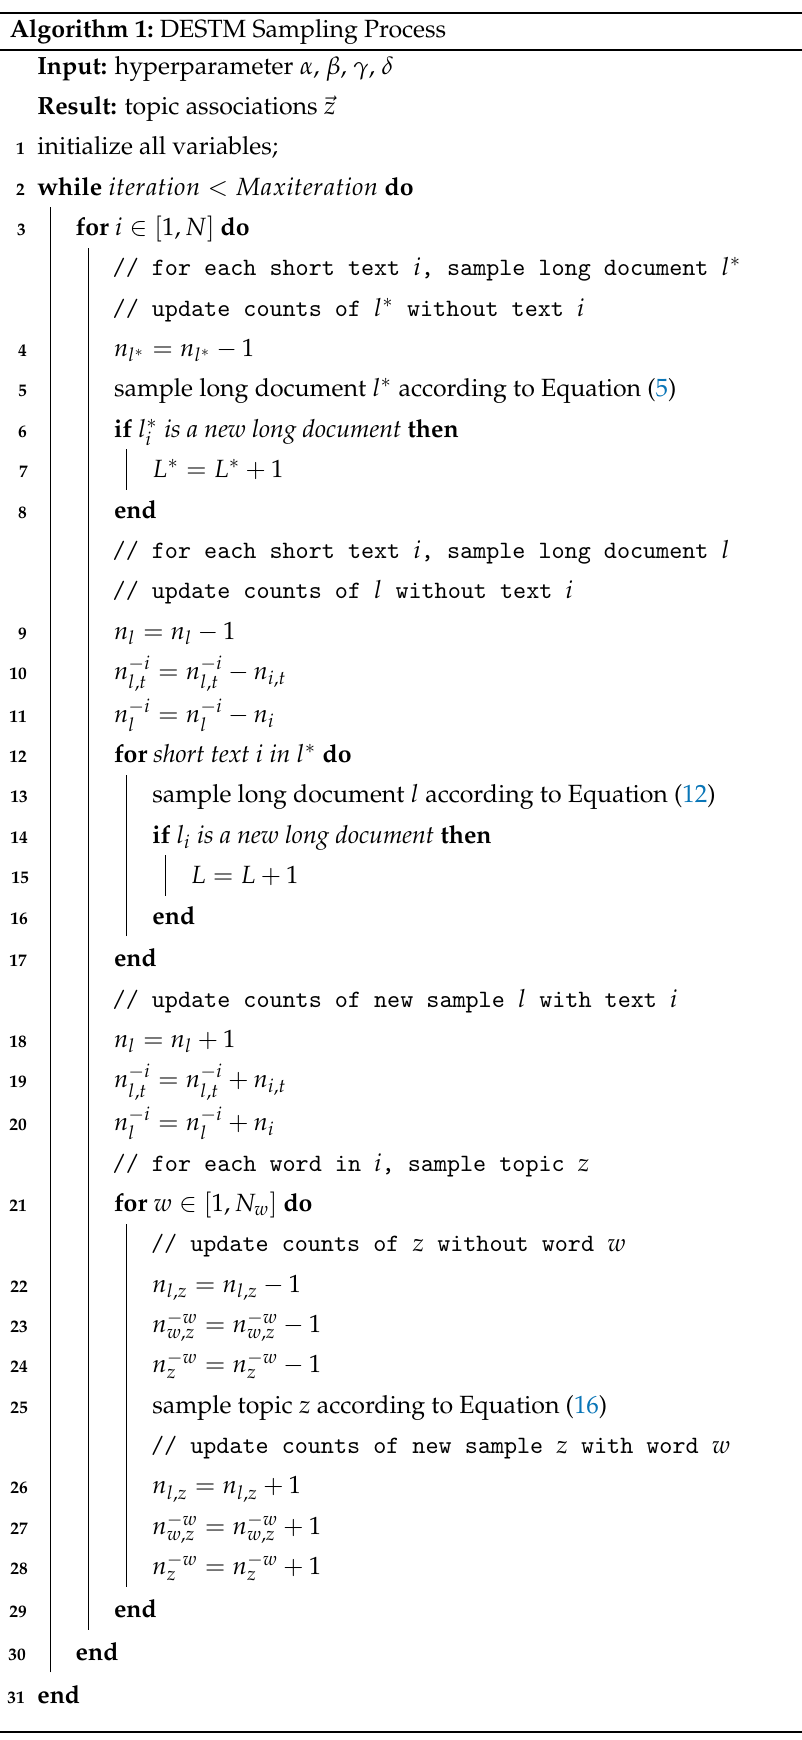
Algorithm 1: DESTM Sampling